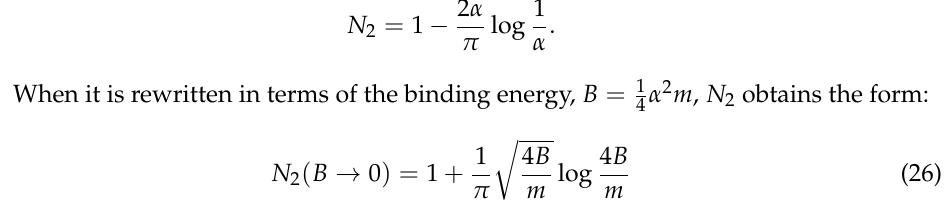
Figure 7. The two-body contribution N 2 vs. the binding energy B for the normal ( κ = 0, n = 1, and n = 2) states. (Adapted from